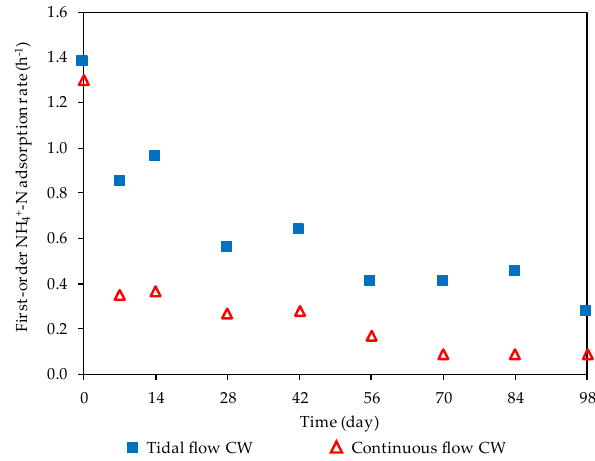
Figure 4. First-order NH 4+ -N adsorption rate on zeolites in tidal flow CWs and continuous flow CWs.